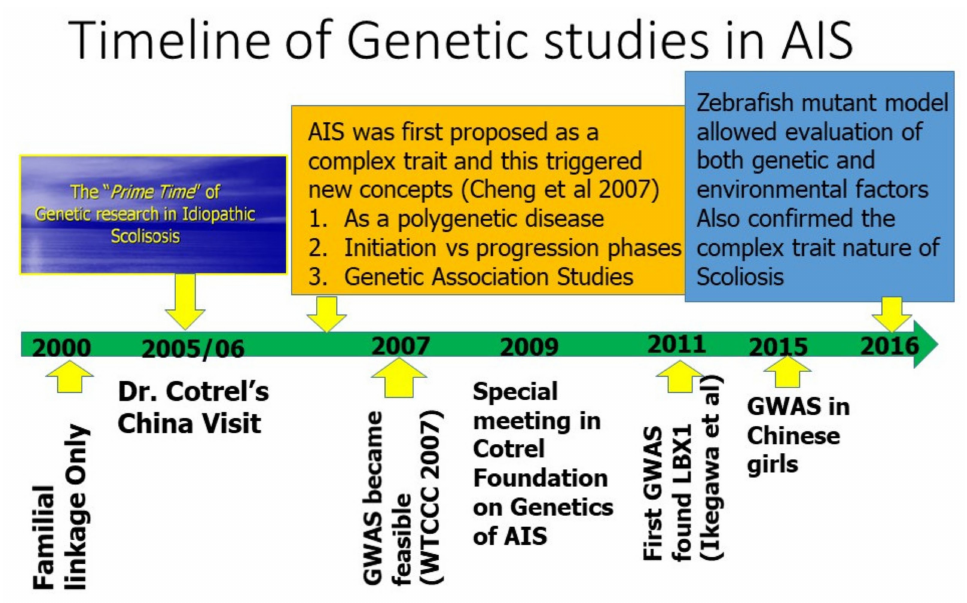
Figure 3. Timeline of genetic research milestones of AIS showing the essential role played by Cotrel Foundation in cultivating complex trait model of